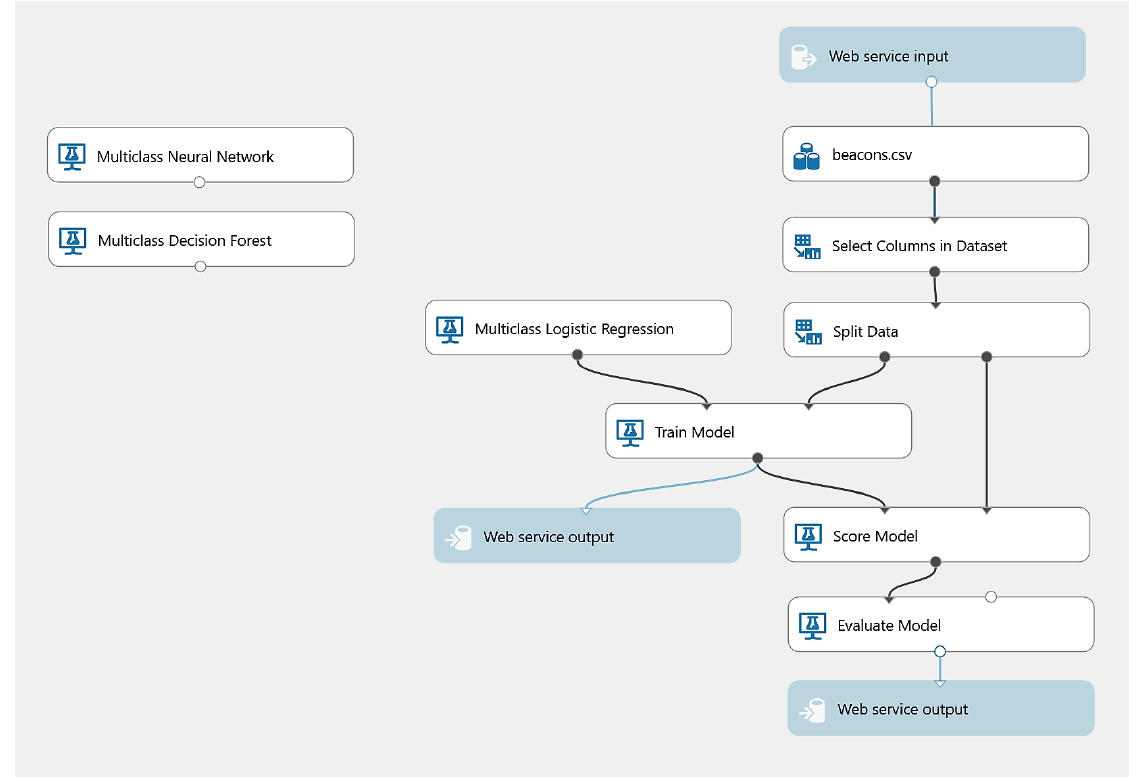
Figure 16. Implementation of the Machine Learning problem with Azure Machine Learning Studio.